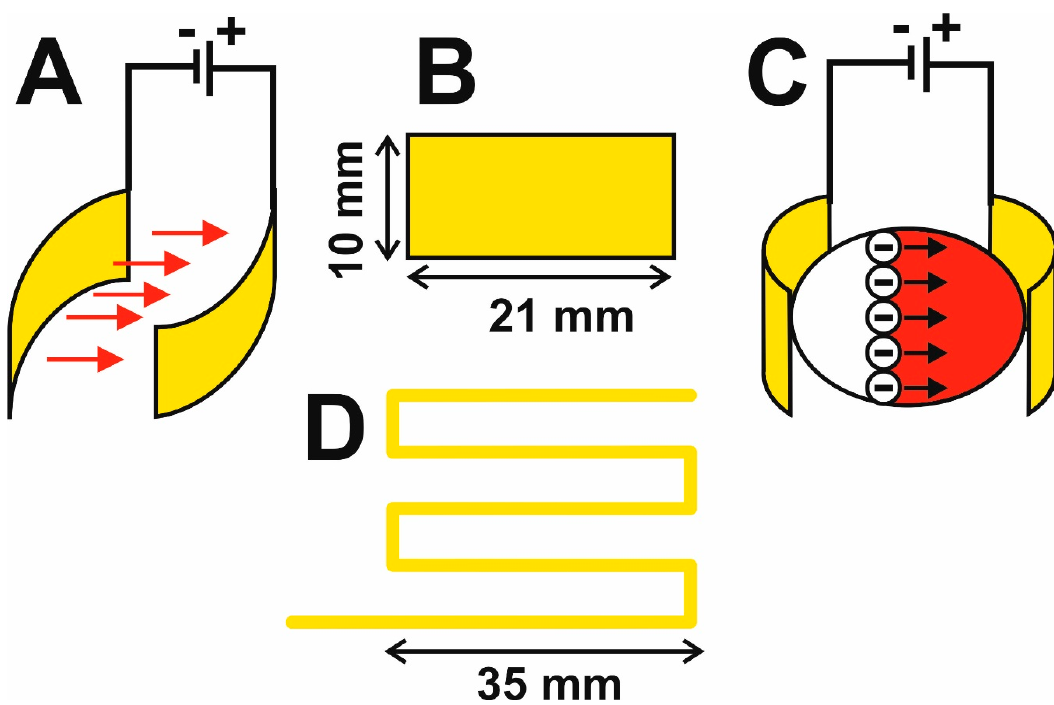
Figure 2. Arrangement of the flat Pt-electrodes inside the cell ( A ); dimensions of the electrodes ( B ); direction of the electrophoretic washing out of the lipids with SDS micelles ( C ); Pt-wire-electrode of the original CLARITY apparatus for comparison ( D